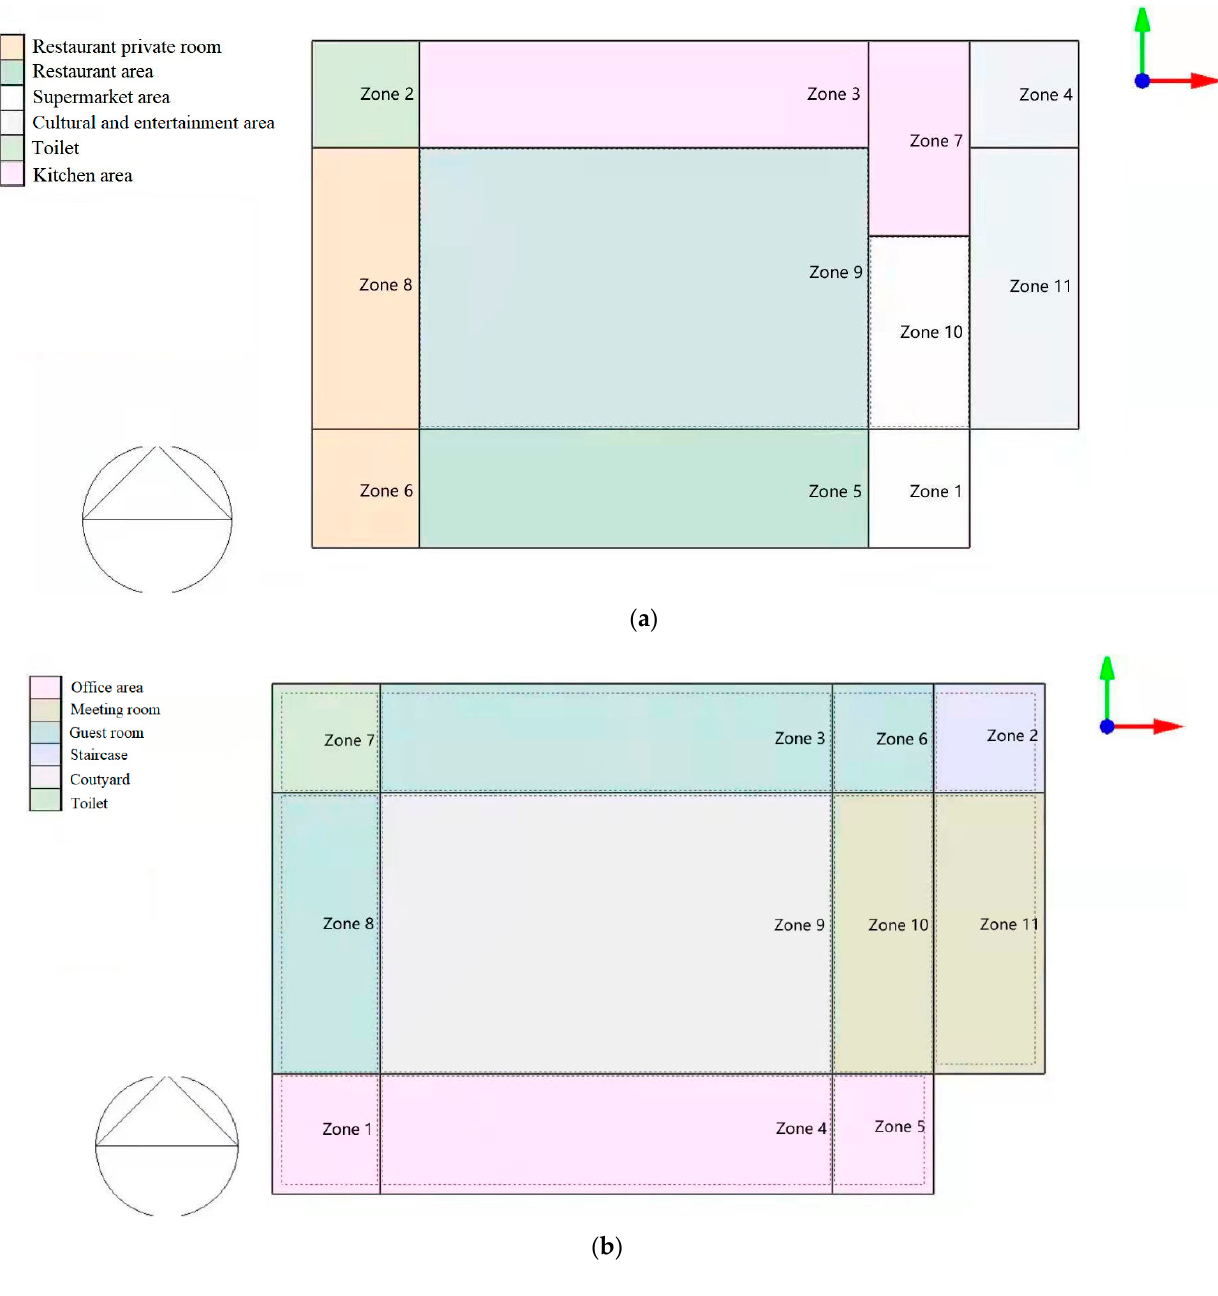
Figure 5. DesignBuilder floor plan of typical expressway service building. ( a ) First floor. ( b ) Second floor.